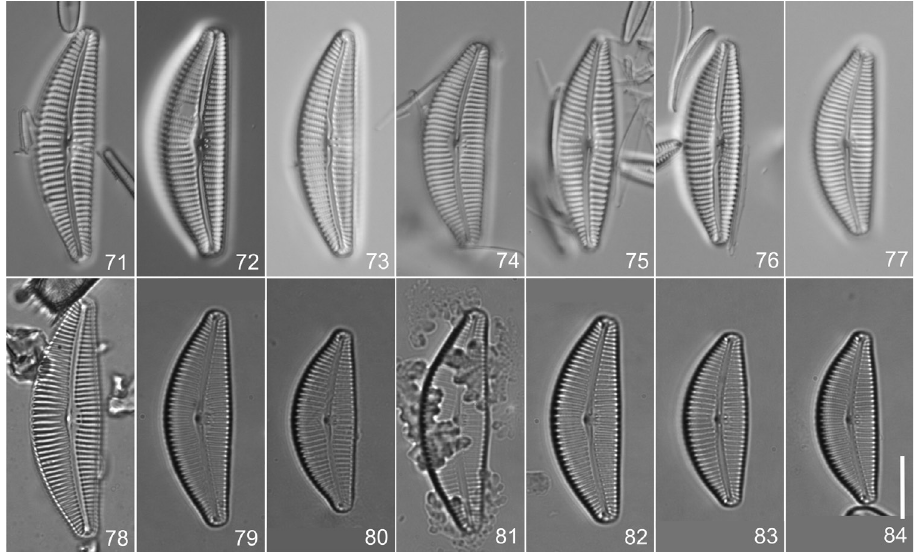
Figures 71–84. Cymbella subturgidula Krammer 71–77 Specimens from Korea in preparation 1046E IOK, holotype 73 Lectotype, designated here 78–80 Specimens from Japan in preparation R 214.928 78 Isolectotype, designated here, of C. turgidula var. nipponica Skvortsov [ ≡ C. rheophila Ohtsuka], heterotypic synonym of Cymbella subturgidula 81 Specimen from Japan in preparation R 214.930 82–84 Specimens from Japan in preparation R 214.932. Scale bar: 10